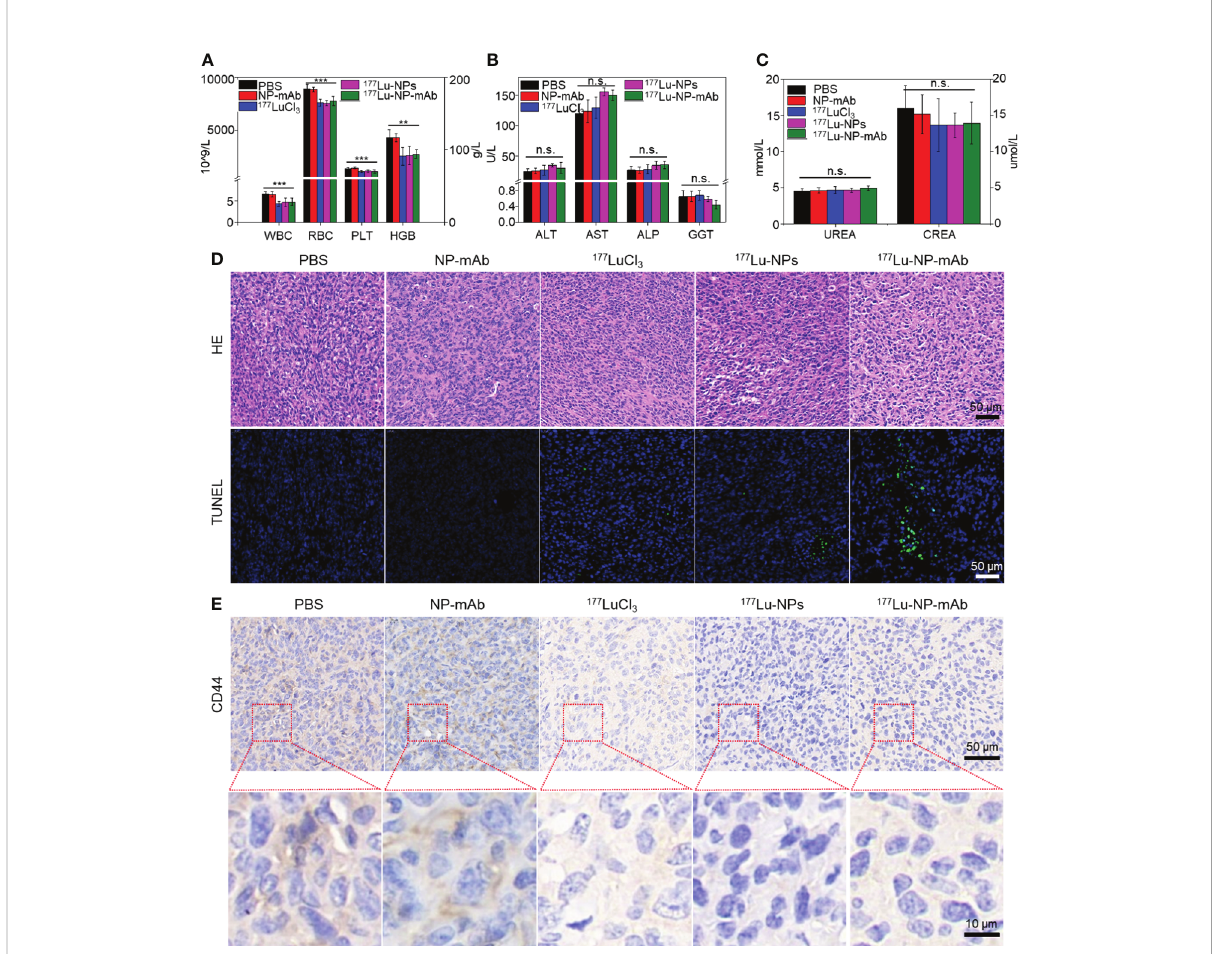
FIGURE 5 Histological evaluation and safety assay. (A) The blood routine tests of mice in different groups after 2 weeks post treatment. Asterisks indicate statistical signi fi cance (**P< 0.01, ***P< 0.001). (B) The liver function of mice in different groups after 2 weeks post treatment (n.s. indicates no signi fi cance). (C) The kidney function of mice in different groups after 2 weeks post treatment (n.s. indicates no signi fi cance). (D) Micrographs of H&E and TUNEL stained tumor slices from metastasis lymph nodes of mice with different groups at 2 weeks after treatment. Scale bar: 50 m m. (E) Micrographs of CD44 stained tumor slices from metastasis lymph nodes of mice with different groups at 2 weeks after treatment. Scale bar: 50/10 m